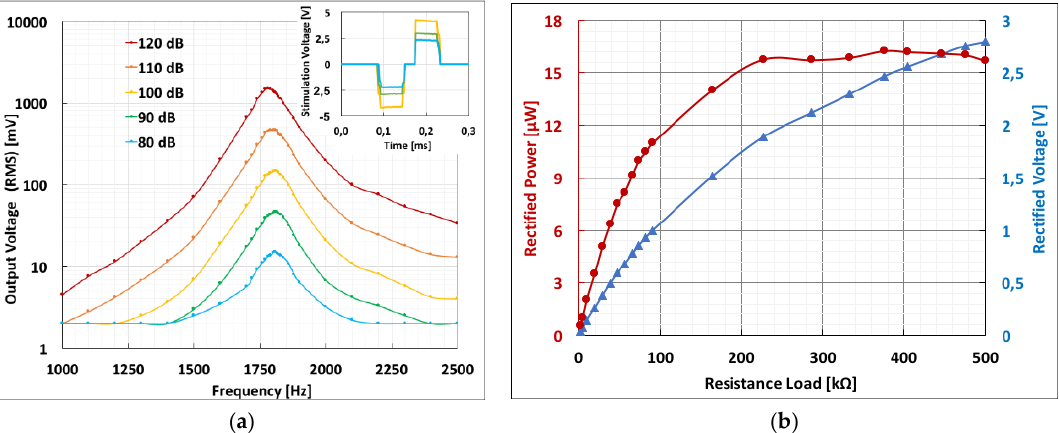
Figure 4. ( a ) Measured frequency sweep results of the prototype chip. Inset is the stimulation signals (biphasic, 1 kHz) of 1.8 kHz input at 80, 90 and 100 dB; ( b ) Rectified power and voltage at 1780 Hz 120 dB-A sound input. Maximum power is 16.25 μW with 2.47 V DC